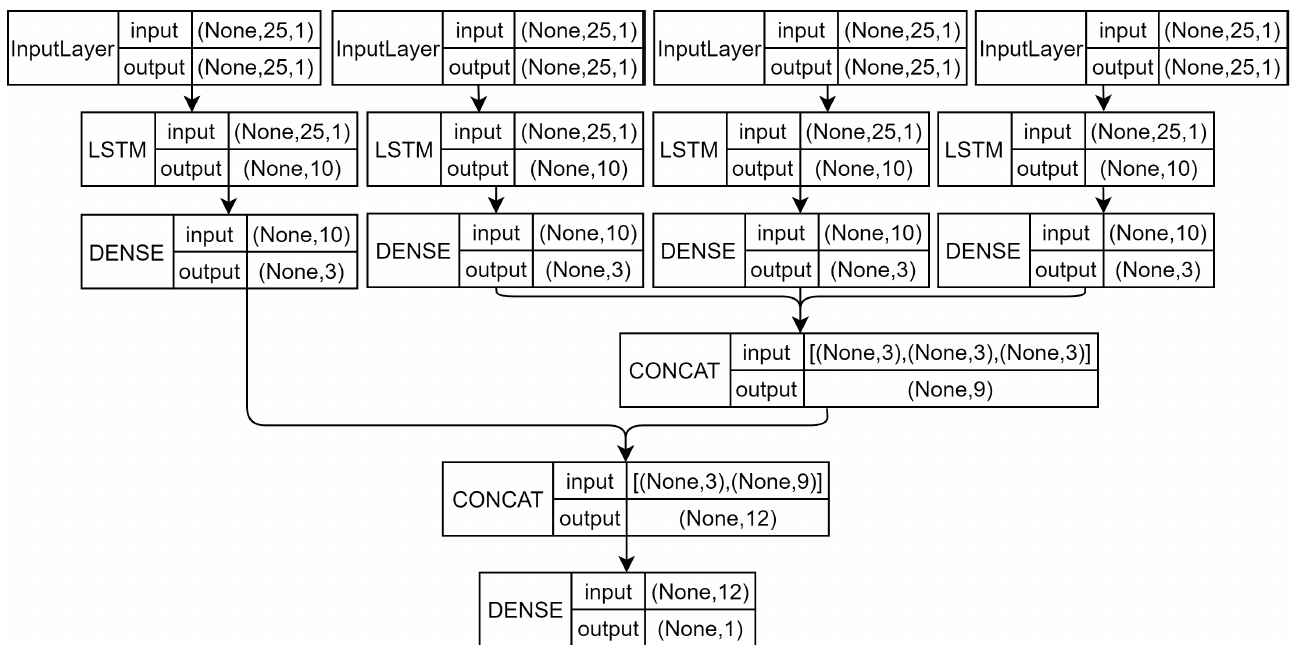
Figure A10. Muñoz’s architecture block diagram.